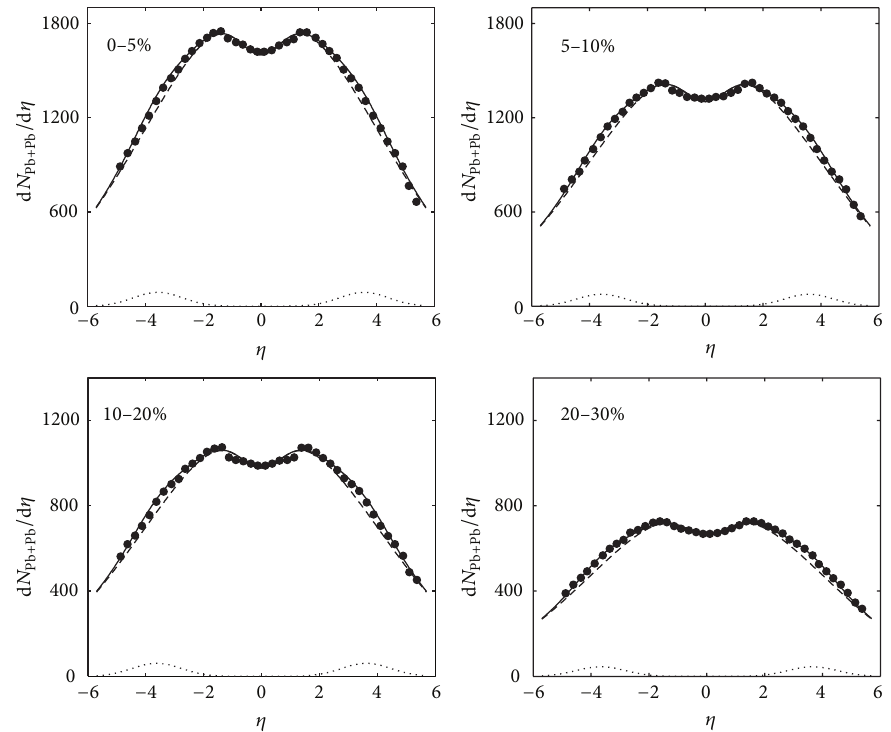
= 2.76 TeV. The NN